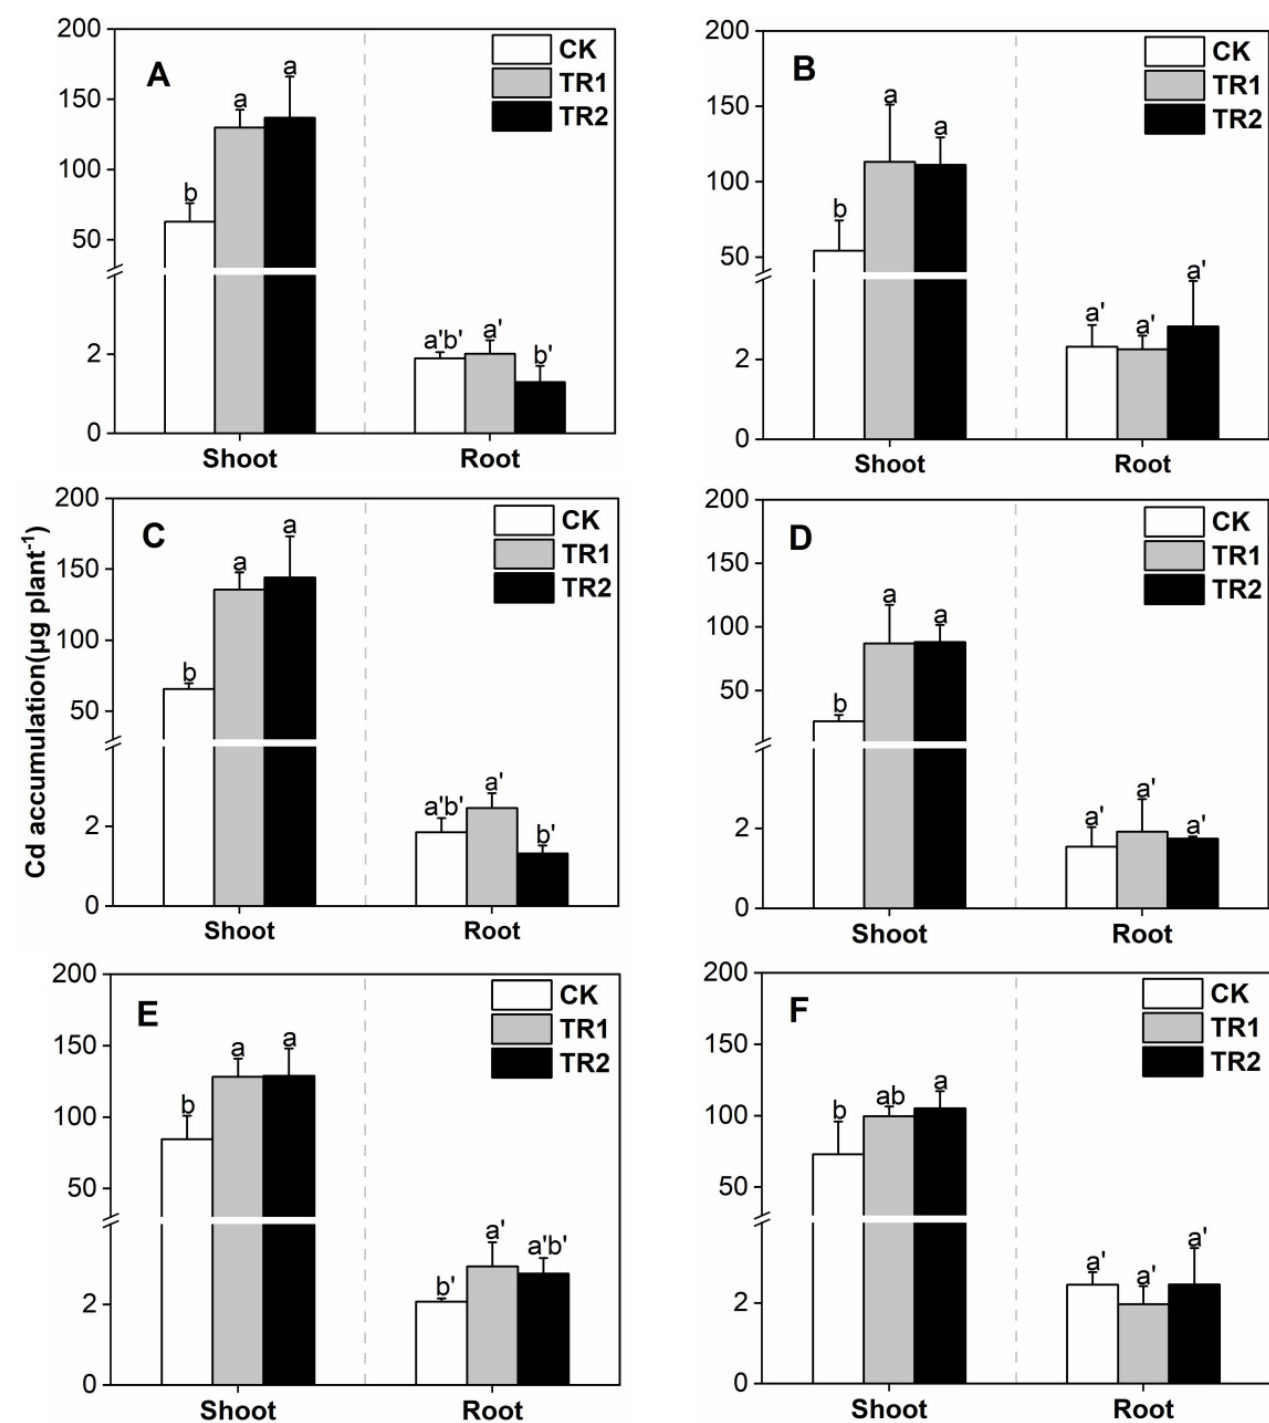
Figure 3. S. alfredii Cd accumulation. ( A ) First period intercropping papaya, ( B ) Second period intercropping papaya, ( C ) First period intercropping grapefruit, ( D ) Second period intercropping grapefruit, ( E ) First period intercropping fig, ( F ) Second period intercropping fig. The different letters above the column indicate the significant differences among different treatments at p < 0.05.